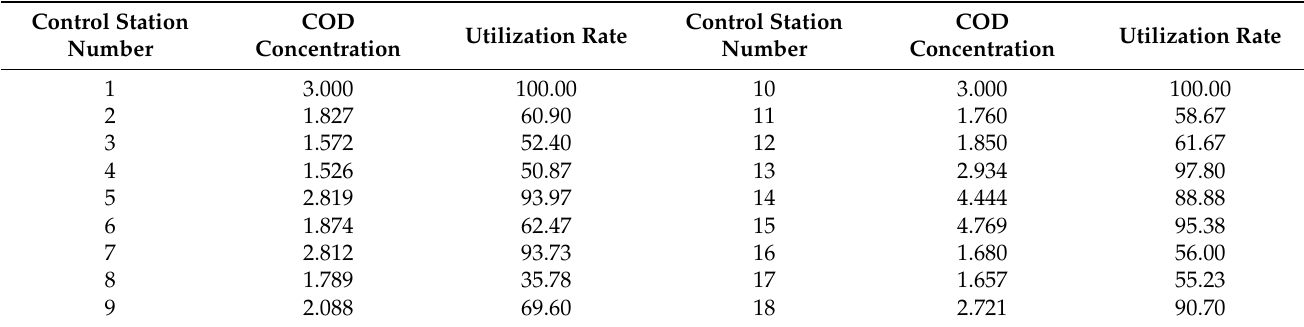
Table 7. Concentration of each control station concentration at the maximum environmental capacity of